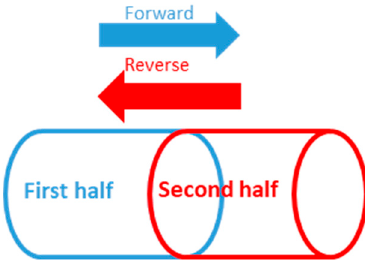
Figure 6. Simulation models composed of the high-pressure upstream (red) and low-pressure downstream (blue) as enclosed by the squares. In the middle of upstream and downstream is the core. ( a ) Ideal case (homogeneous) simulation model using average permeability values of the forward and backward flow history matchings with only U 1 under high pressure. ( b ) History matching simulation model using experimental data with combined U 1 and U 2 , with the initial upstream pressure of p u ’ and the initial downstream pressure of p d ’ , as illustrated in Figure 2.